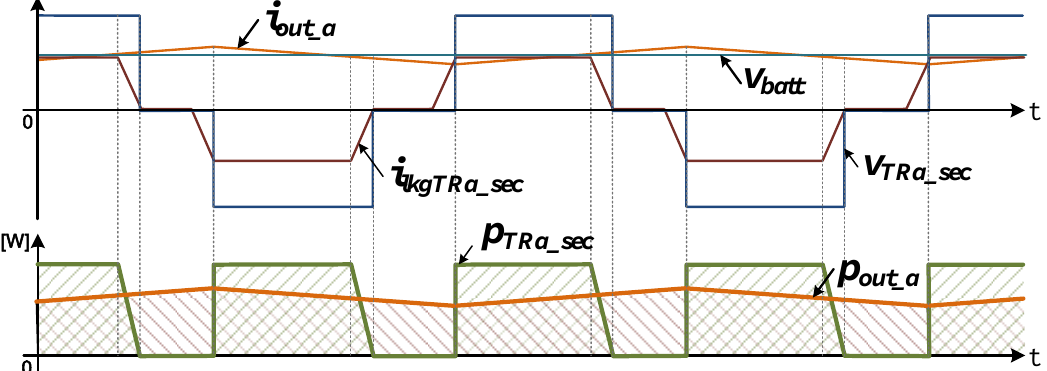
Figure 8. The relationship of secondary side voltage, current, and power with output inductor current and power.